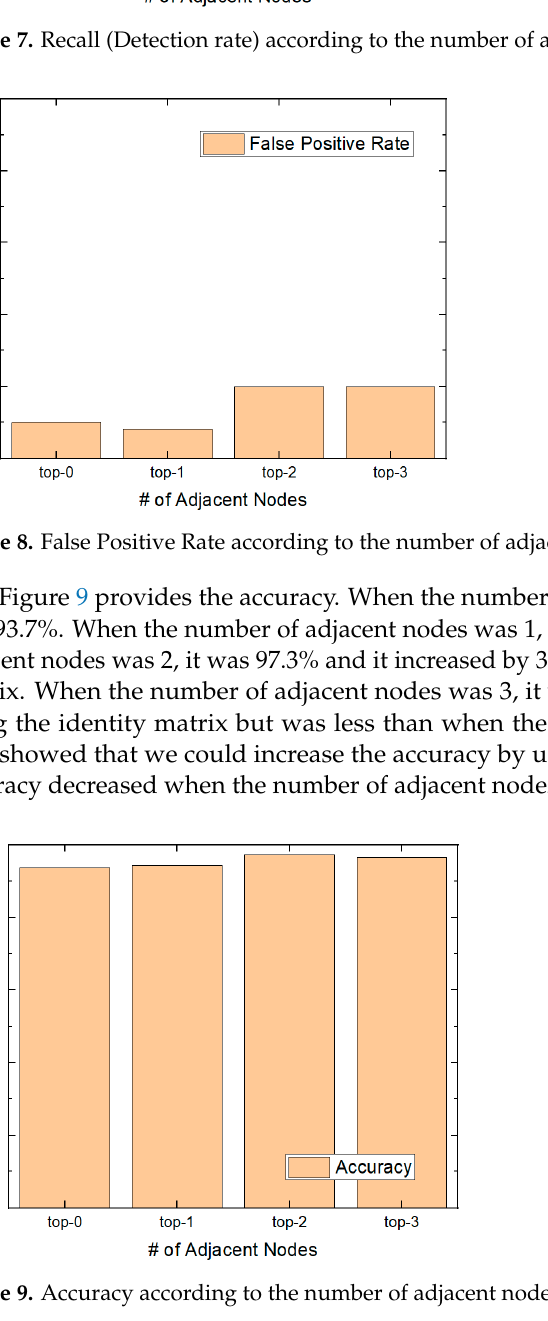
Figure 9. Accuracy according to the number of adjacent nodes.